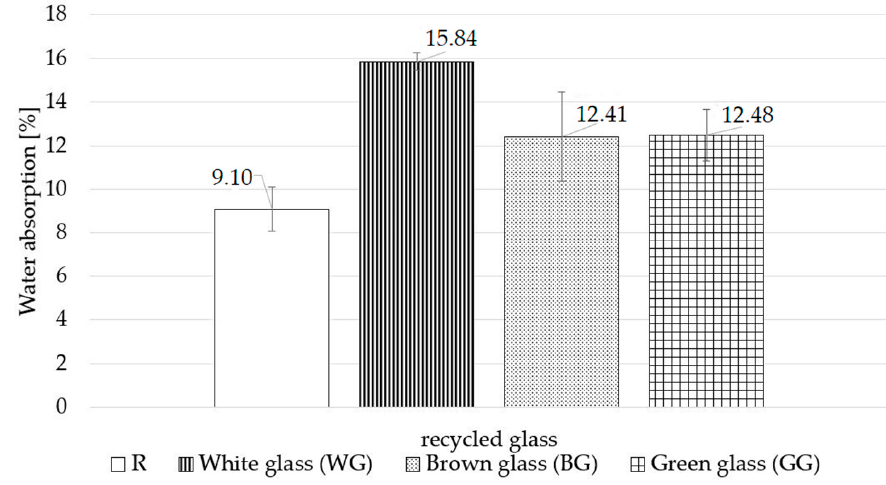
Figure 7. Results of water absorption.